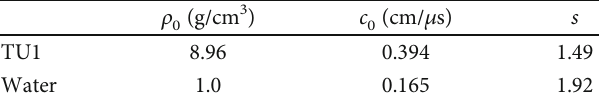
Table 3: The parameters of Hugoniot curve.